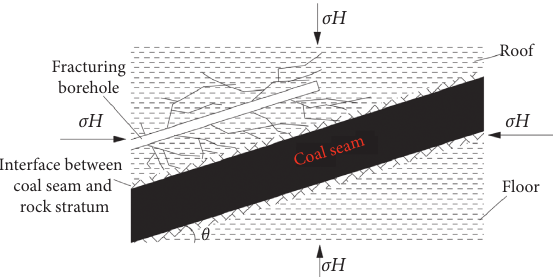
Figure 2: Model of multiple fractures in horizontal well intersecting coal-rock interface.